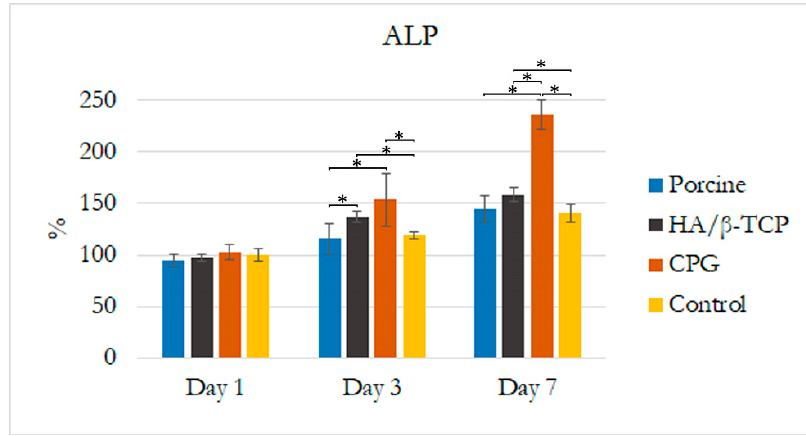
Figure 4. Effects of CPG, porcine graft, and HA/ β -TCP on alkaline phosphatase (ALP) activity of MG-63 osteoblast-like cells after seven days. Results are expressed as percentages of control and are the means ± standard error. Statistically significant differences were set at p < 0.05 and are indicated by asterisks